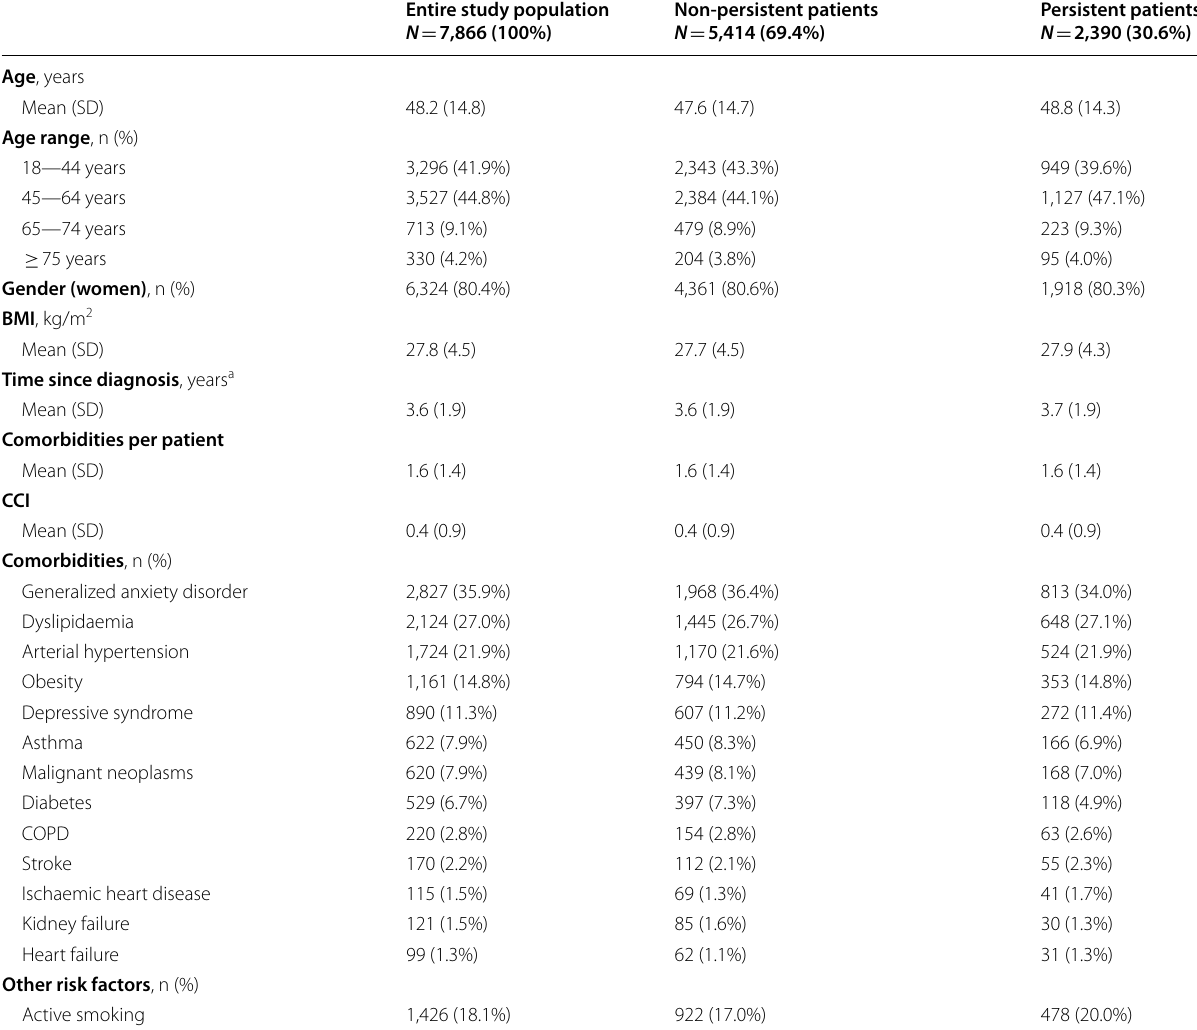
Table 1 Demographic and clinical characteristics of migraine patients at baseline and in non‑persistent and persistent study groups